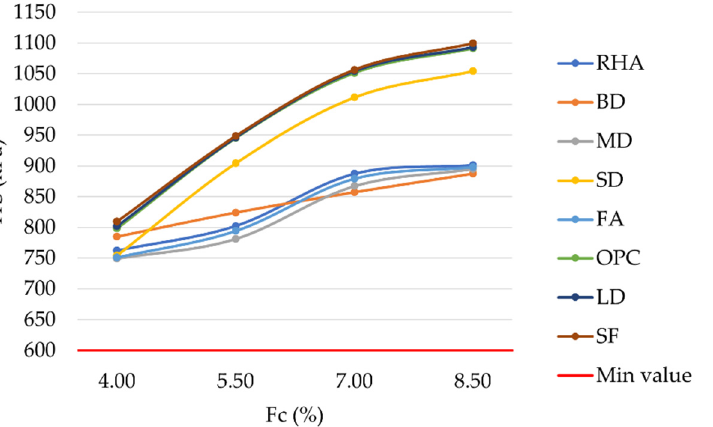
Figure 9. Indirect tensile strength vs. filler content for mixtures prepared with conventional and waste fillers.